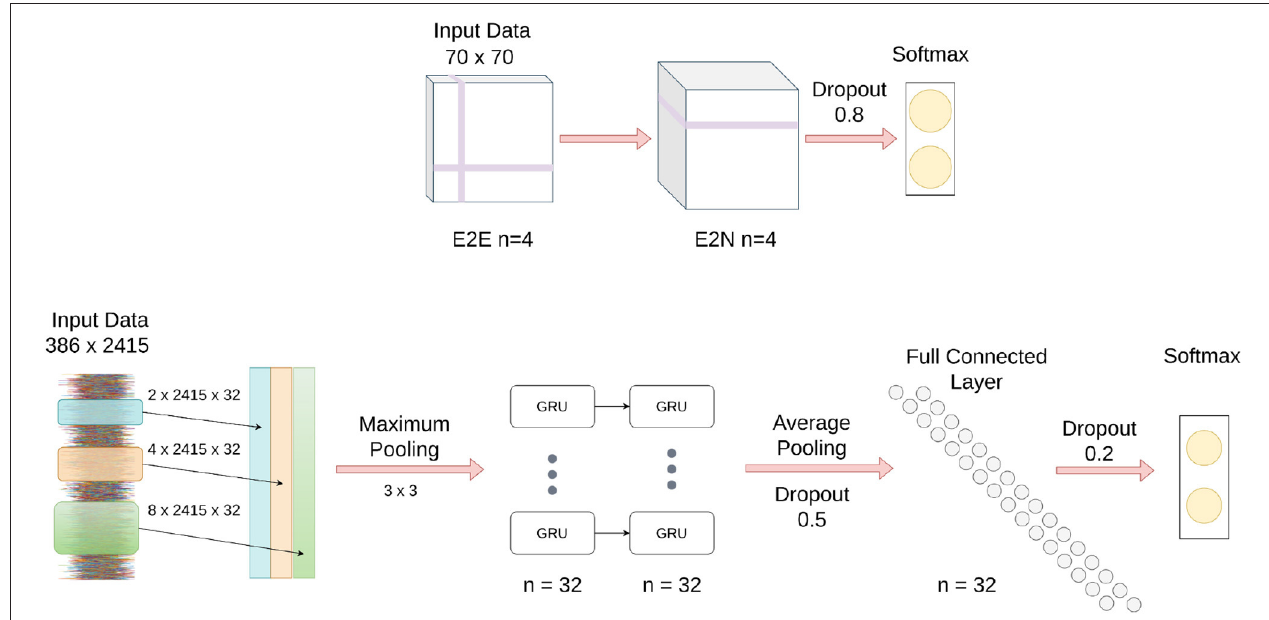
FIGURE 2 | Schematic of Brainnet CNN and MsRNN architecture. (Top) Brainnet CNN; the edge to edge (E2E) layer uses a crosshair convolution filter, and the edge to node (E2N) layer uses a 1D convolution row filter. (Bottom) MsRNN; three varied convolutions are first performed in the input layer, the output is then concatenated, and finally maximum pooled before being fed into the gated recurrent units (GRUs).